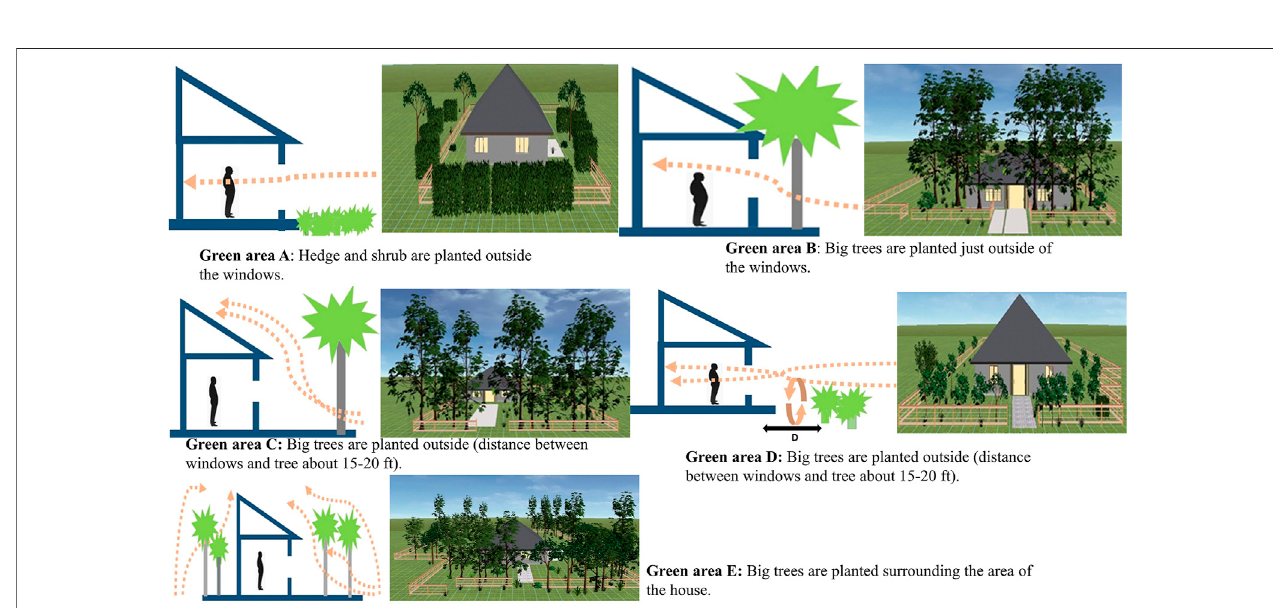
Frontiers in Built Environment |